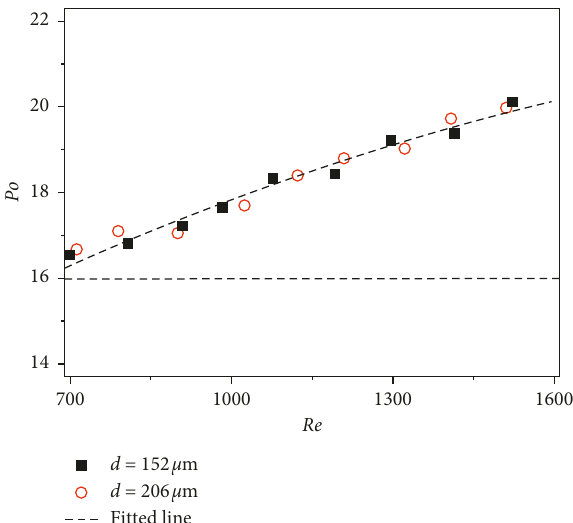
Figure 8: Influence of the Reynolds number on the Poiseuille number of liquid flow in